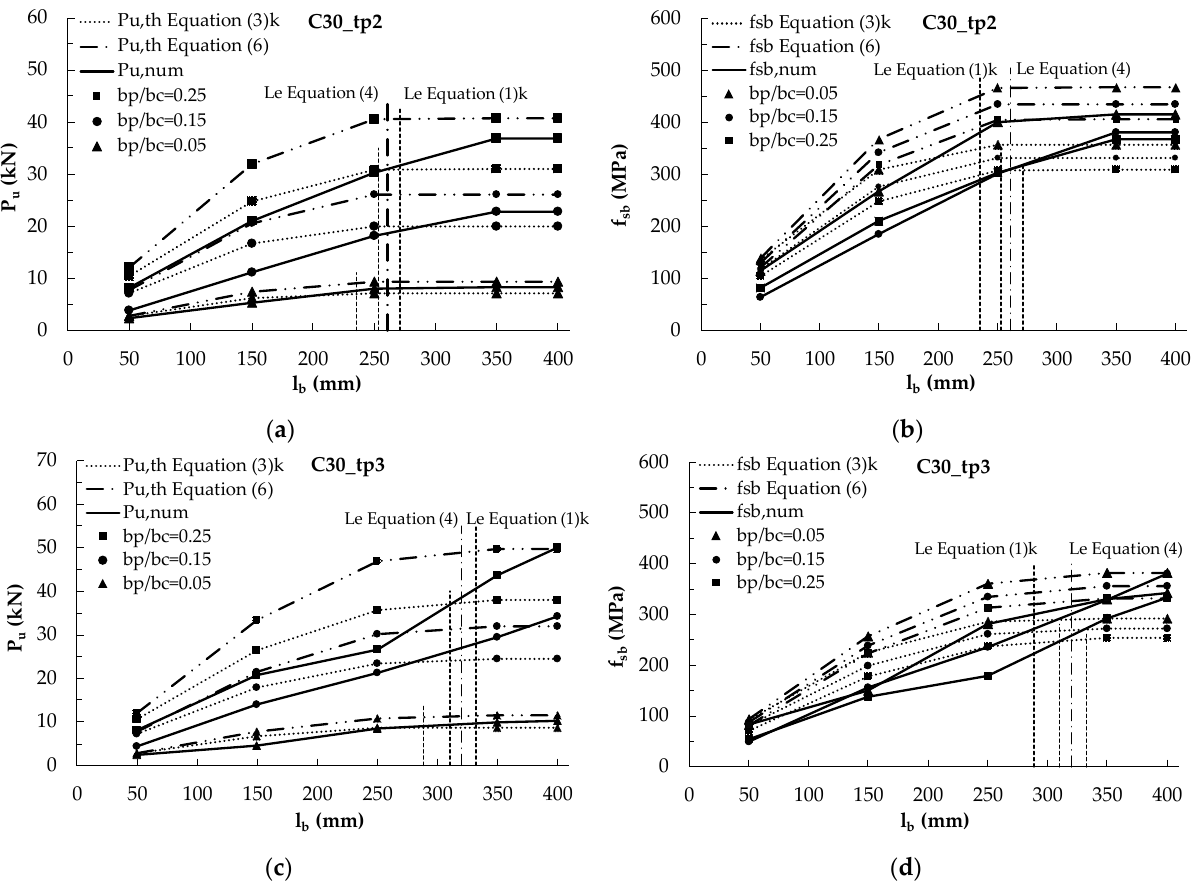
Figure 9. Numerical and characteristic theoretical debonding loads (Equations (3) and (6)) vs. bonded length for a concrete C30 and different values of b p /b c for: ( a ) t p = 2 mm; ( c ) t p = 3 mm; ultimate stresses vs. bonded length: ( b ) t p = 2 mm; ( d ) t p = 3 mm.